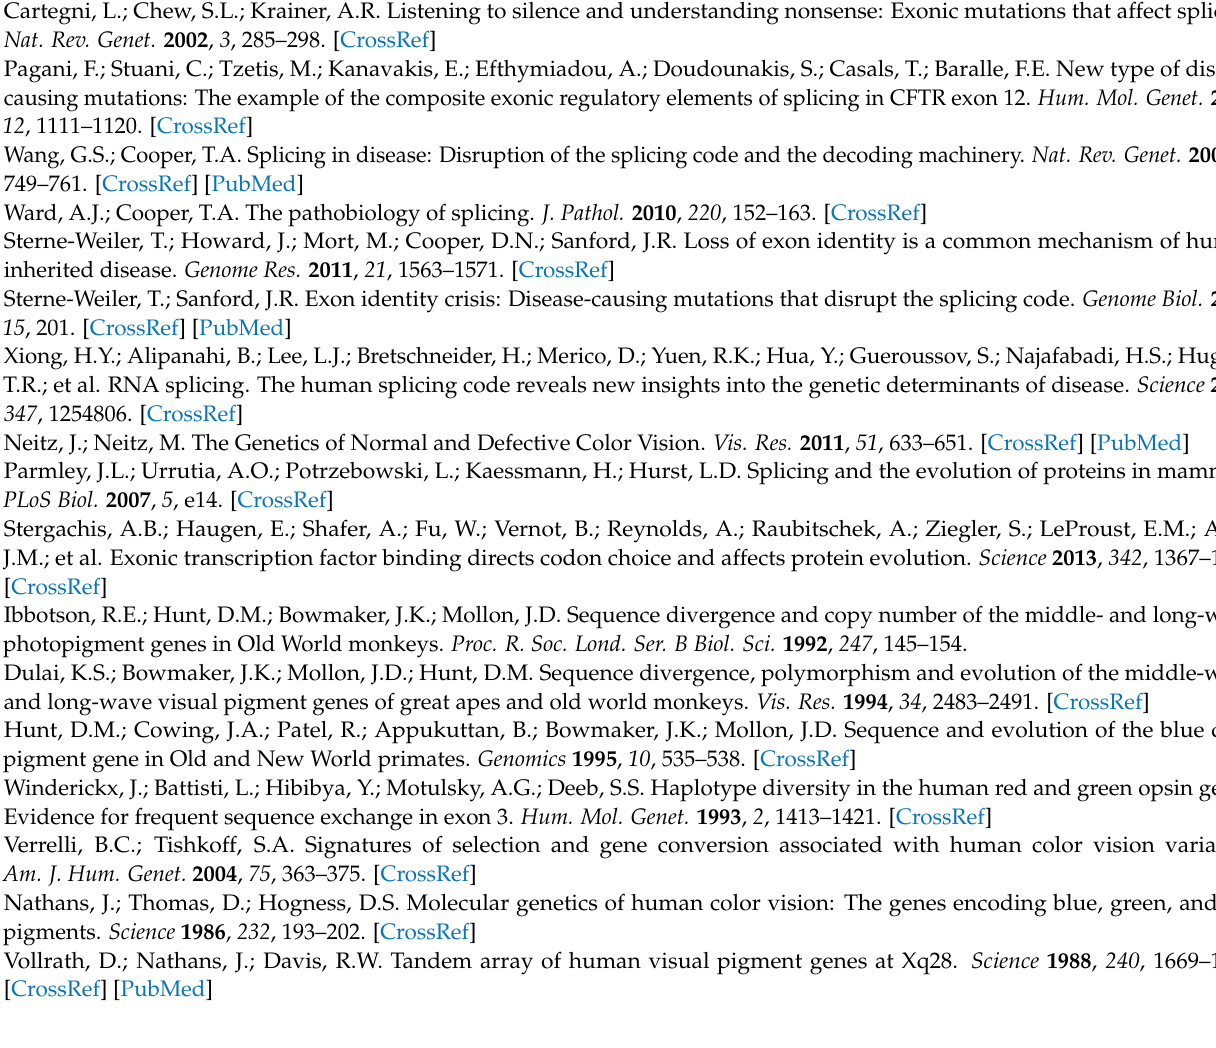
Table S6: MVAVA haplotype and arrays for normal color vision, Table S7: LIAVS